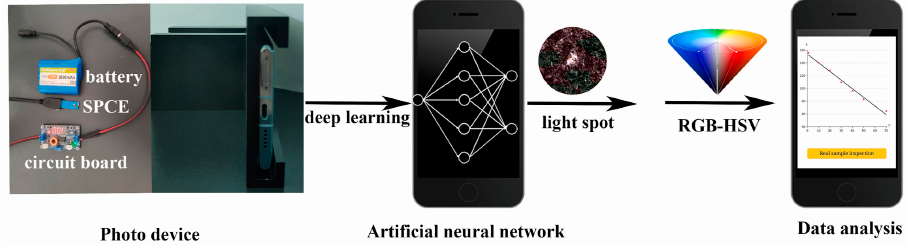
Figure 8. Illustration of a smartphone-based sensing platform [57]. Copyright 2022 Elsevier (Amster- dam, The Netherlands).